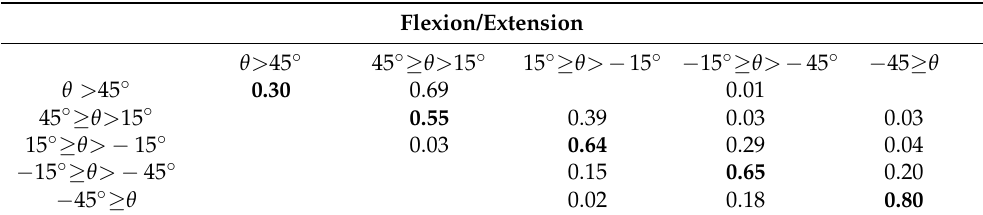
Table 1. Contingency table of cumulative model performance in flexion/extension with the true posture shown vertically and the predicted posture horizontally.